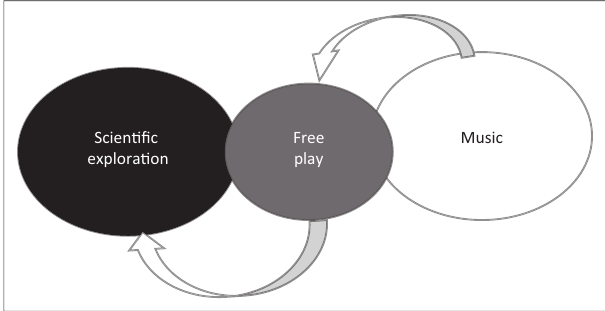
FIGURE 2: Concept map of music-inspired free play to foster scientific